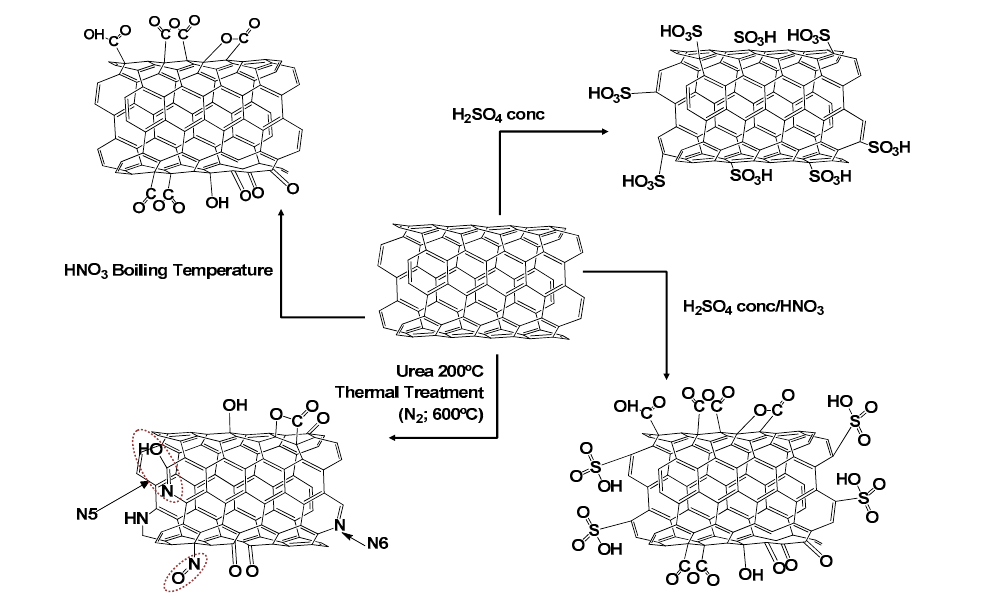
Figure 6. Schematic liquid-phase functionalization routes to incorporate different O, N and S heteroatoms onto the surface of CNTs. Reprinted from reference [56] with permission from Elsevier.